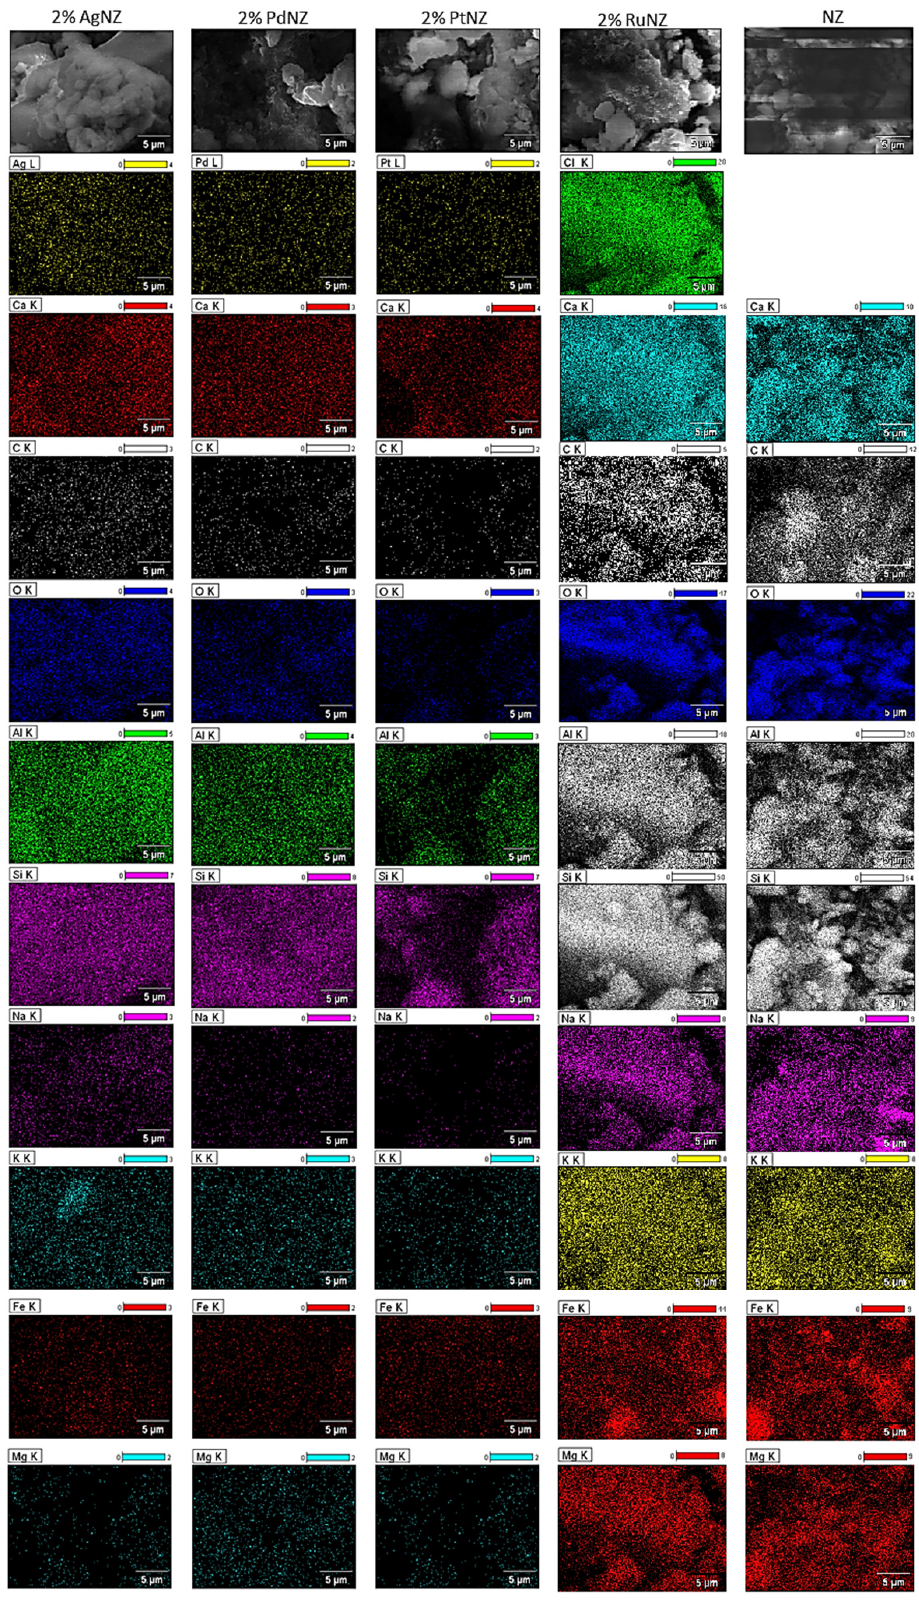
Figure 7. SEM-EDS images of the calcined support NZ and monometallic M/NZ catalysts in an air atmosphere at 400 °C for 4 h.